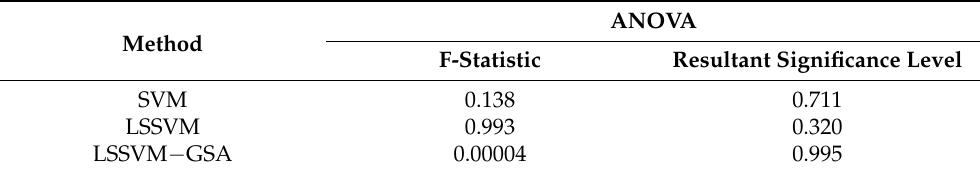
Table 6. Analysis of variance for estimating C d in the testing